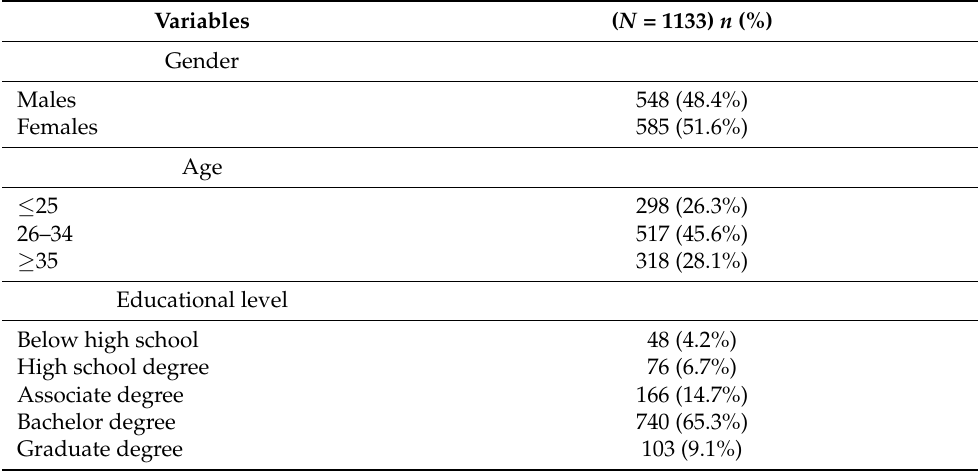
Table 1. Sociodemographic characteristics of the